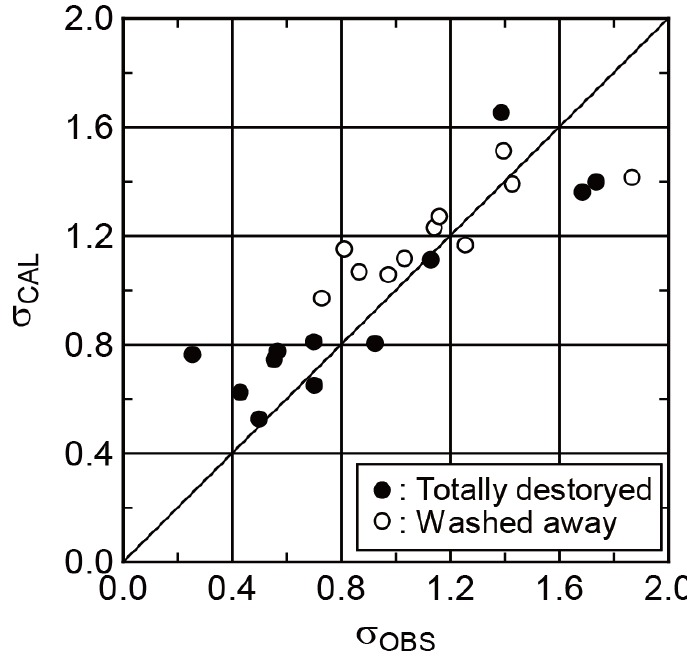
Figure 13. Comparison of observed and calculated values of σ .